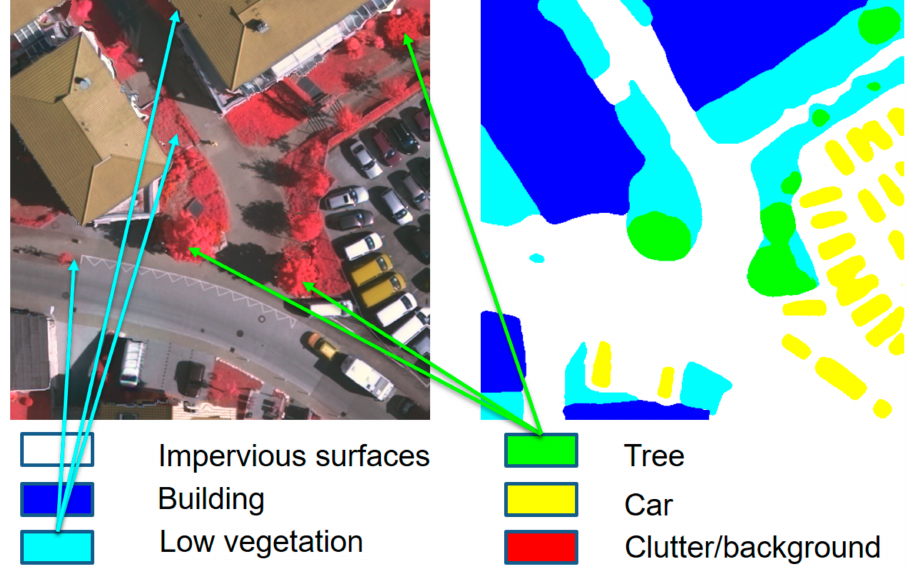
Figure 9. Scale difference in Vaihingen